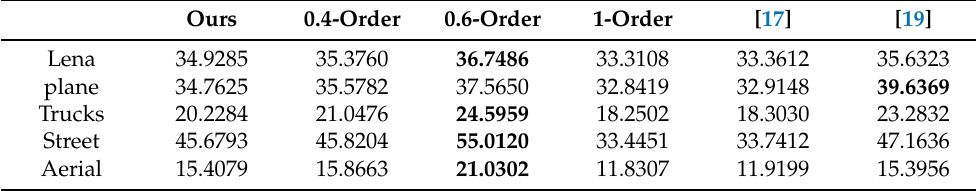
Table 3. Under different algorithms, the contrast values of different images.